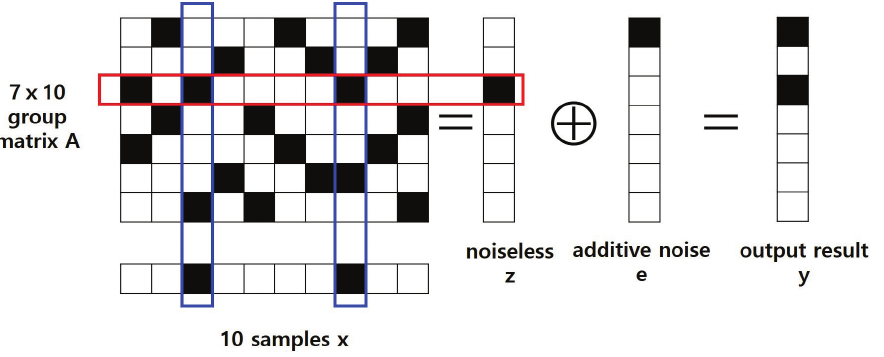
Figure 1. One example of NTGT where M = 7, N = 10, T = 2, the black boxes denotes 1 s, and white ones 0